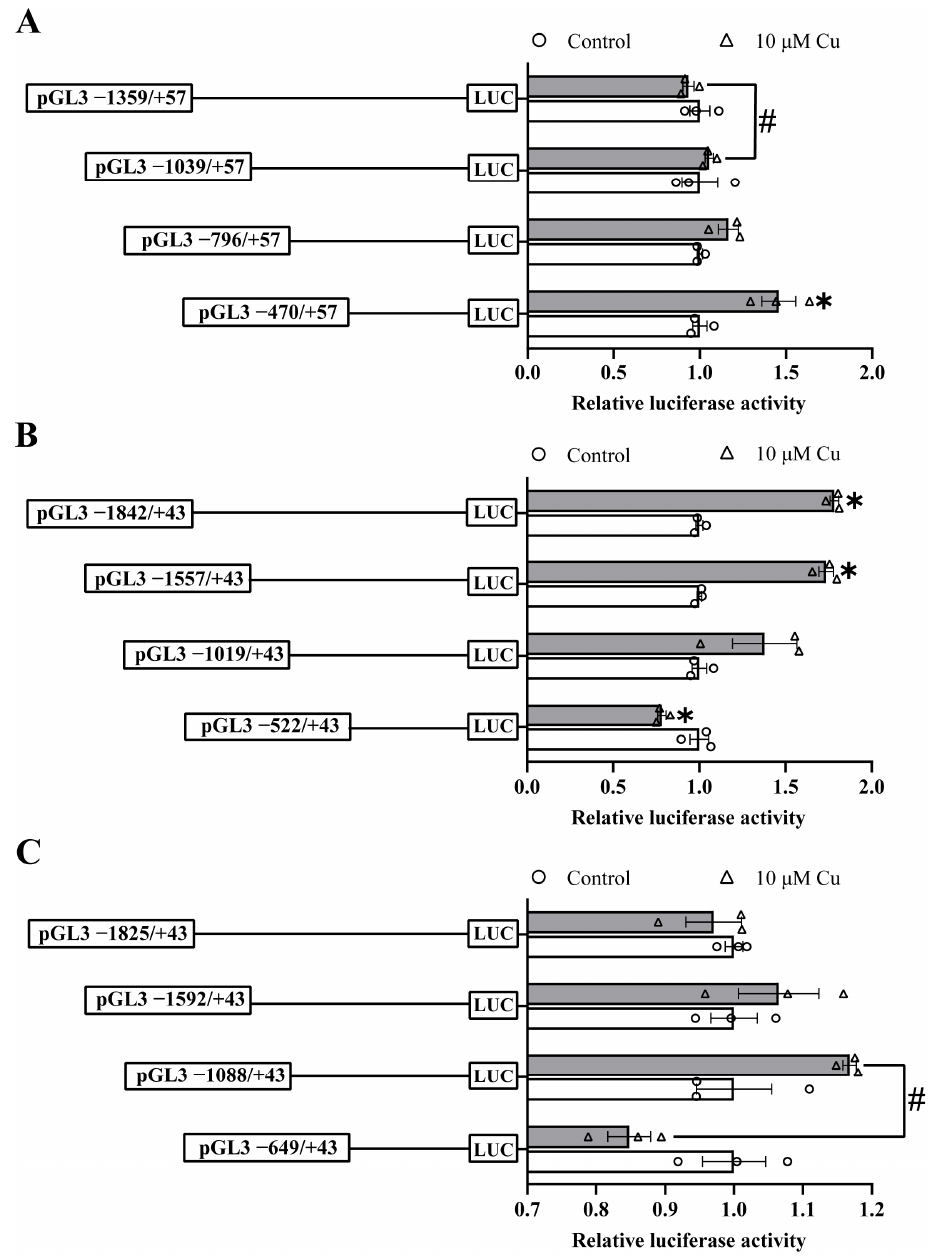
Figure 2. 5 ′ unidirectional deletion assays for ctr1 ( A ), ctr2 ( B ) and atox1 ( C ) promoters after 10 μ M Cu incubation. Values show the ratio of activities of Firefly to Renilla luciferase, normalized to the control, and are presented as means ± SEM (n = 3). Asterisk (*) indicates significant differences in relative luciferase activities between the Cu-treated group and the control in the same fragment ( p < 0.05); hash symbol (#) indicates significant differences in relative luciferase activities between the two fragmentss under the same treatment ( p <